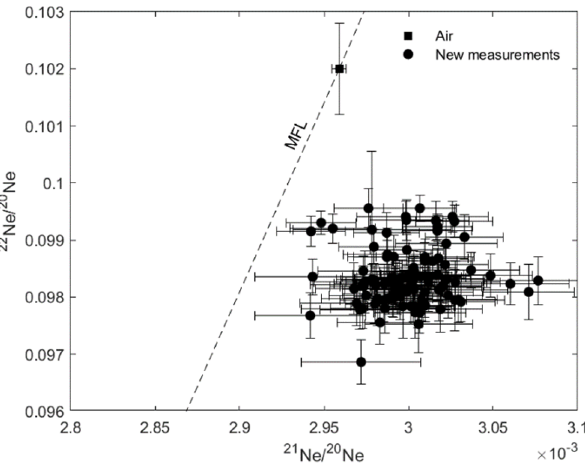
Figure 4. Ne isotope ratio from the repeated analysis of air using the ARGUS VI mass spectrometer. The delivery amount was 9.36 ± 0.21 × 10 − 14 cm 3 STP 21 Ne/aliquot, equivalent of 21 Ne from 7.7 mg CREU. The repeatability of 21 Ne/ 20 Ne was 1.1% (1 σ ) (n = 103), which was a significant achievement at this partial pressure of Ne. The repeatability of 22 Ne/ 20 Ne was 0.62% and was likely governed by the 7% CO 2 correction at mass 22. All data were located slightly right of the mass fractionation line (MFL), indicating a constant excess at m / z = 21, which was unchanged over an order of magnitude of Ne partial pressure and was corrected out (see text). Air is from Refs. [6,22]. Plotted uncertainties are 1 σ .